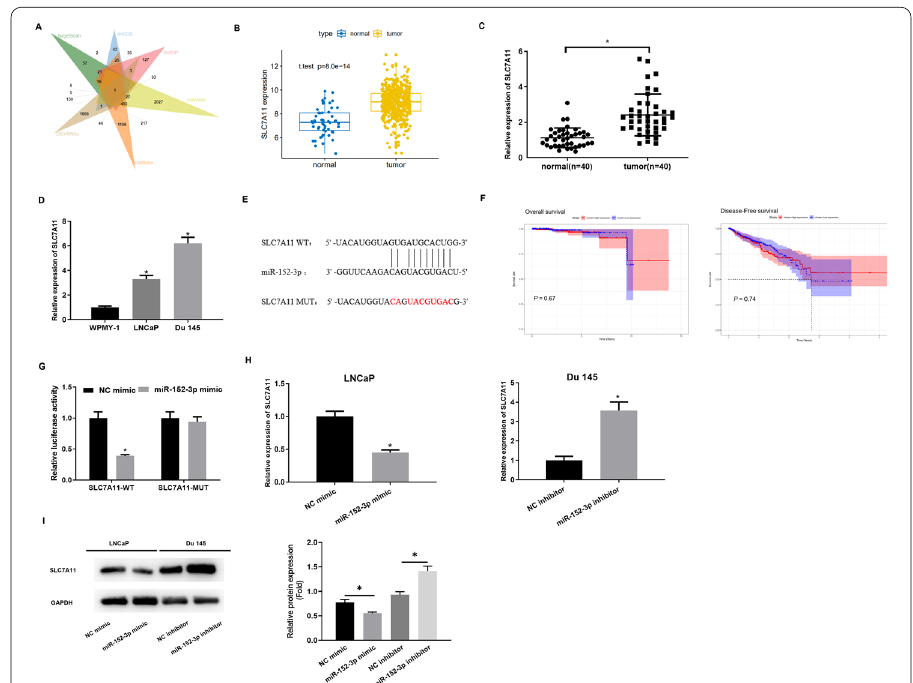
Fig. 4 SLC7A11 is the direct target of miR-152-3p. A Venn diagram of predicted target mRNAs and differential mRNAs; B SLC7A11 expression in TCGA database in normal and tumor groups; C SLC7A11 level in PCa clinical tissue and non-tumor adjacent tissue (normal 40, tumor 40); D SLC7A11 level in PCa = = and normal cell lines. The experiment was repeated 3 times, * p < 0.05; E binding sequence of SLC7A11 and miR-152-3p; F Kaplan–Meier survival analysis of overall survival and disease-free survival between SLC7A11 high expression and low expression patients in TCGA database. G Dual-luciferase assay confirmed targeted relationship of miR-152-3p and SLC7A11. The experiment was repeated 3 times, * p < 0.05; H , I SLC7A11 mRNA and protein levels in Du 145 cells after overexpression or inhibition of miR-152-3p. The experiment was repeated 3 times, * p <